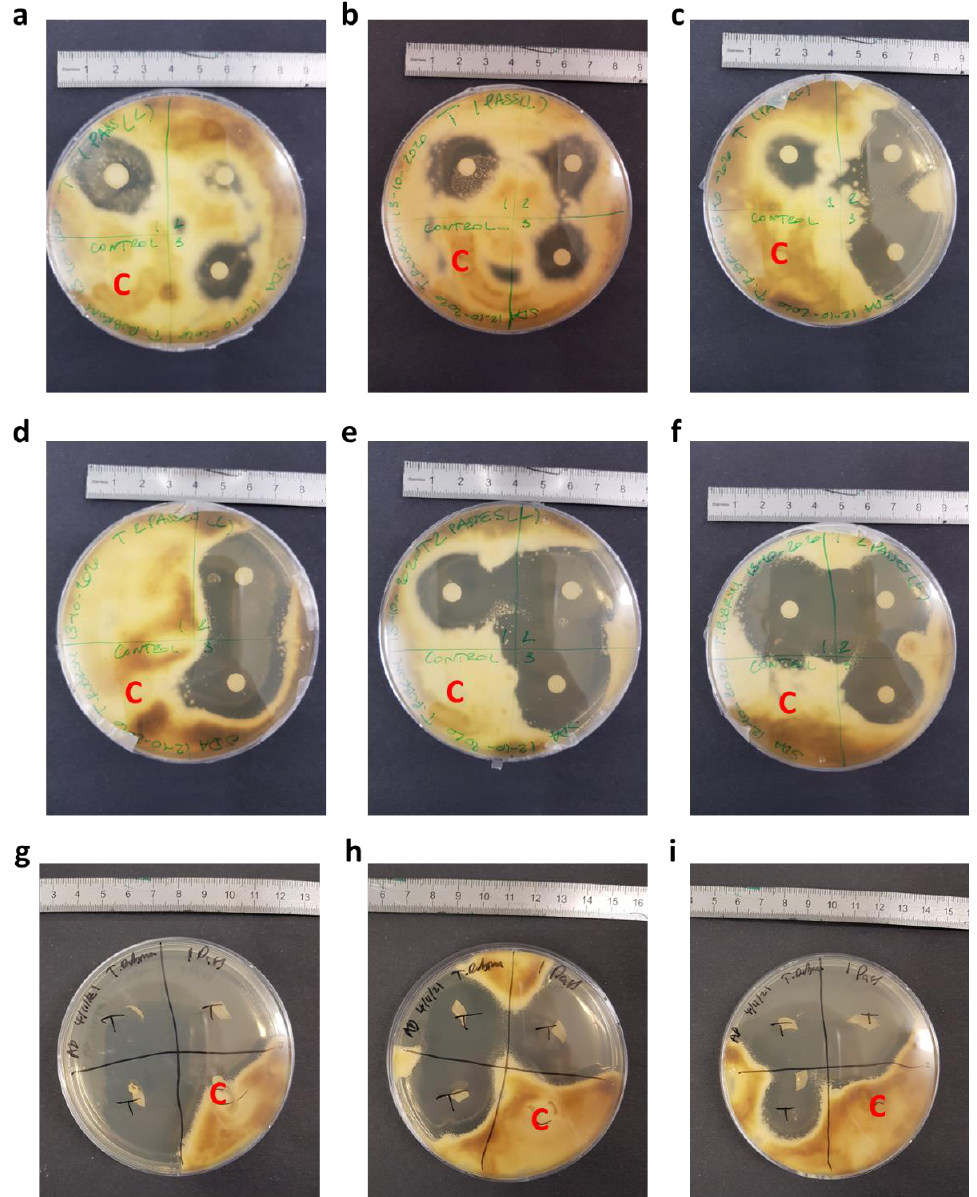
Figure 6. Photographic images of the assay plates, demonstrating the inhibition of T. rubrum by both printed-on discs and printed-on nails. ( a – c ) Disc diffusion assay for 1 pass of terbinafine HCl at 29 µg/mL. ( d – f ) Disc diffusion assay for 2 passes of terbinafine HCl at 29 µg/mL. ( g – i ) Nail diffusion assay for 1 pass of Terbinafine HCl at 5 mg/mL. The units on the rulers shown are cm, and the control quadrants are labelled with a red ‘C’. The quadrants labelled ‘1’, ‘2’, ‘3’ and ‘T’ are all test quadrants.